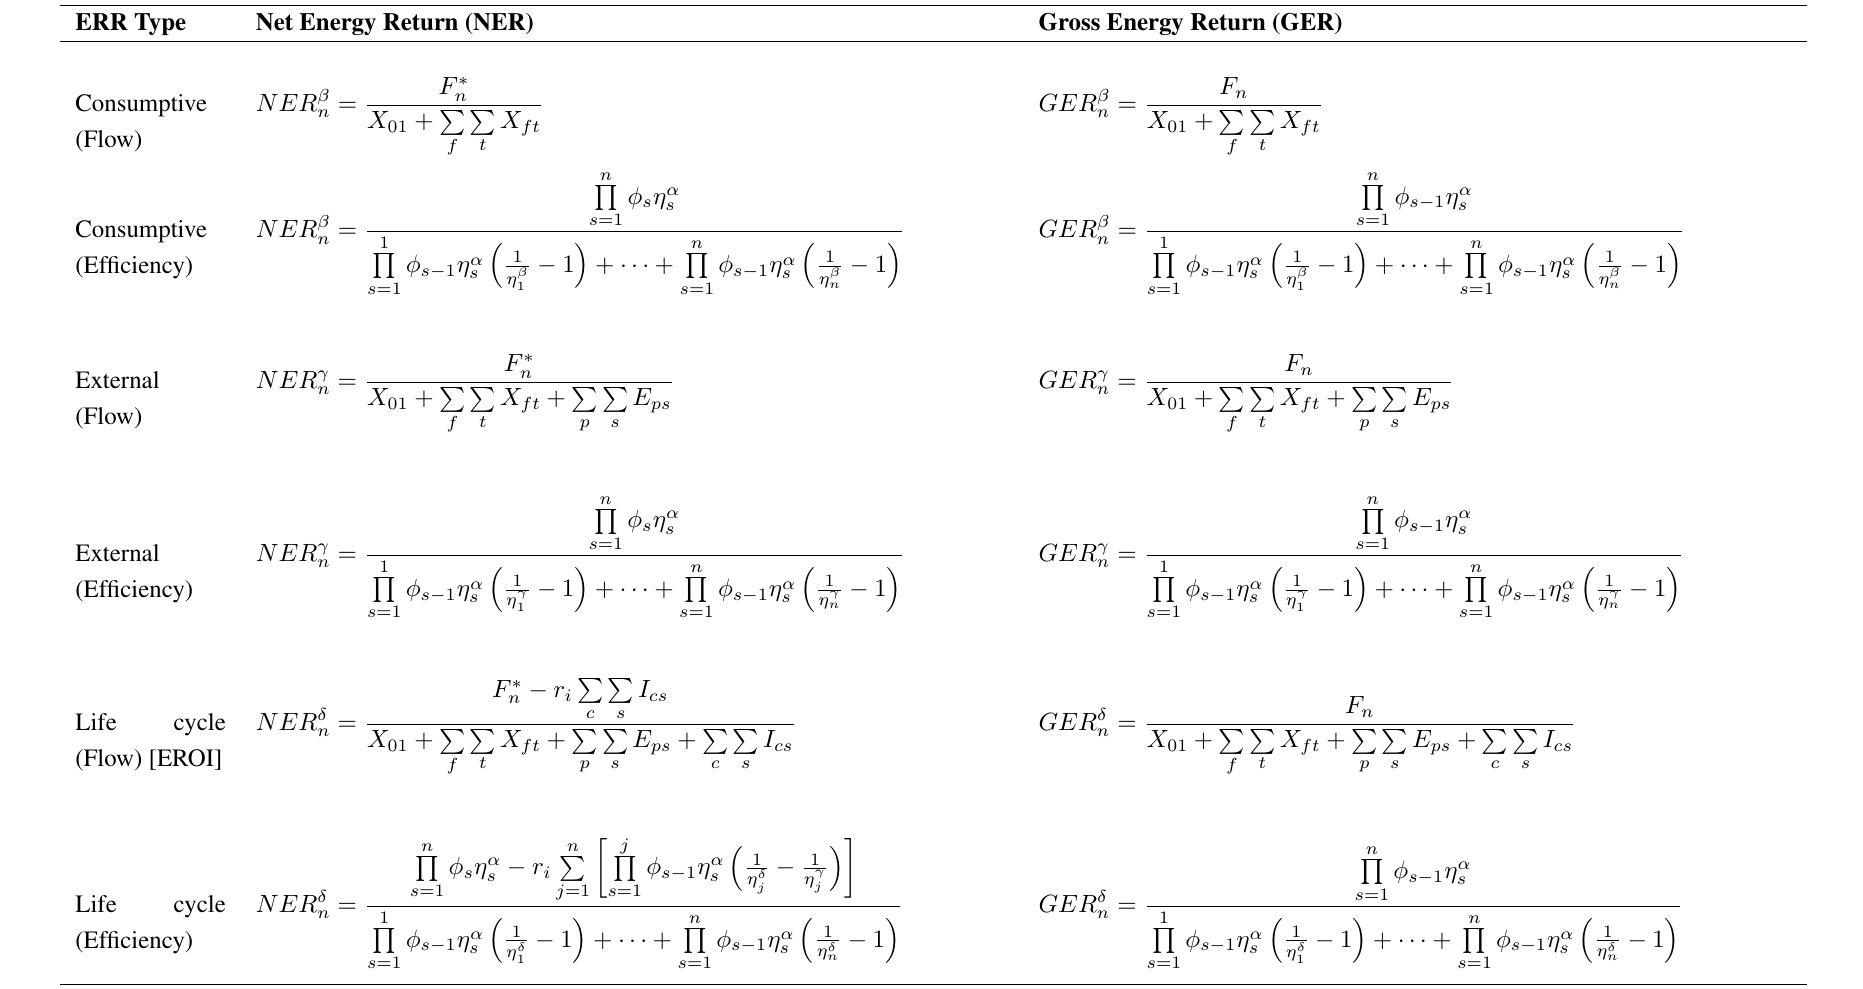
Table 1. NER and GER formulations based on flows of energy (flow-based) and process stage efficiencies (efficiency-based). The EROI as generally practiced would fall under the heading of a life-cycle based